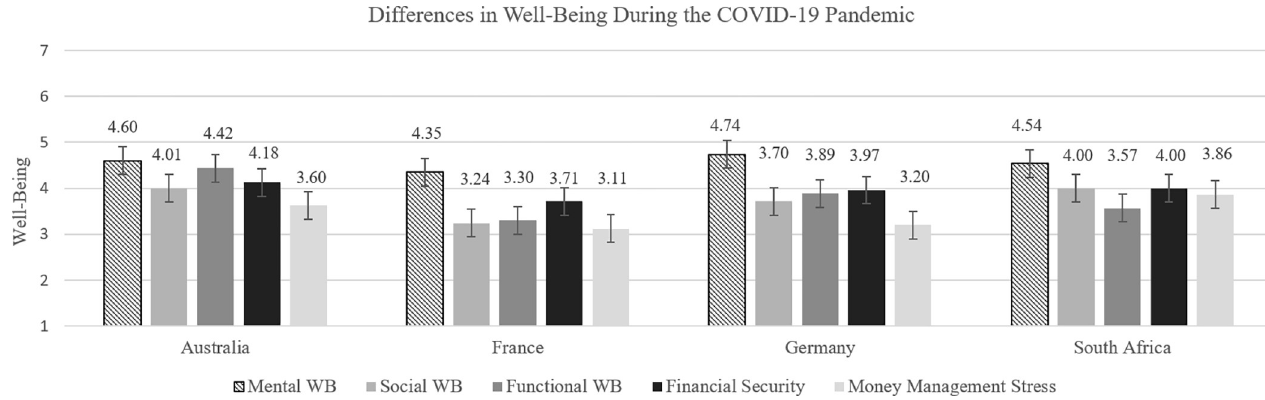
Fig 1. Differences in survey respondents’ individual well-being across Australia, France, Germany and South Africa during the COVID-19 pandemic. This figure presents the means of mental, social, functional, and financial well-being (expected financial security and current money management stress) of survey respondents during the COVID-19 pandemic as of May 2021. The scale ranges from 1 = low well-being to 7 = high well-being. The bars show 5% confidence intervals.